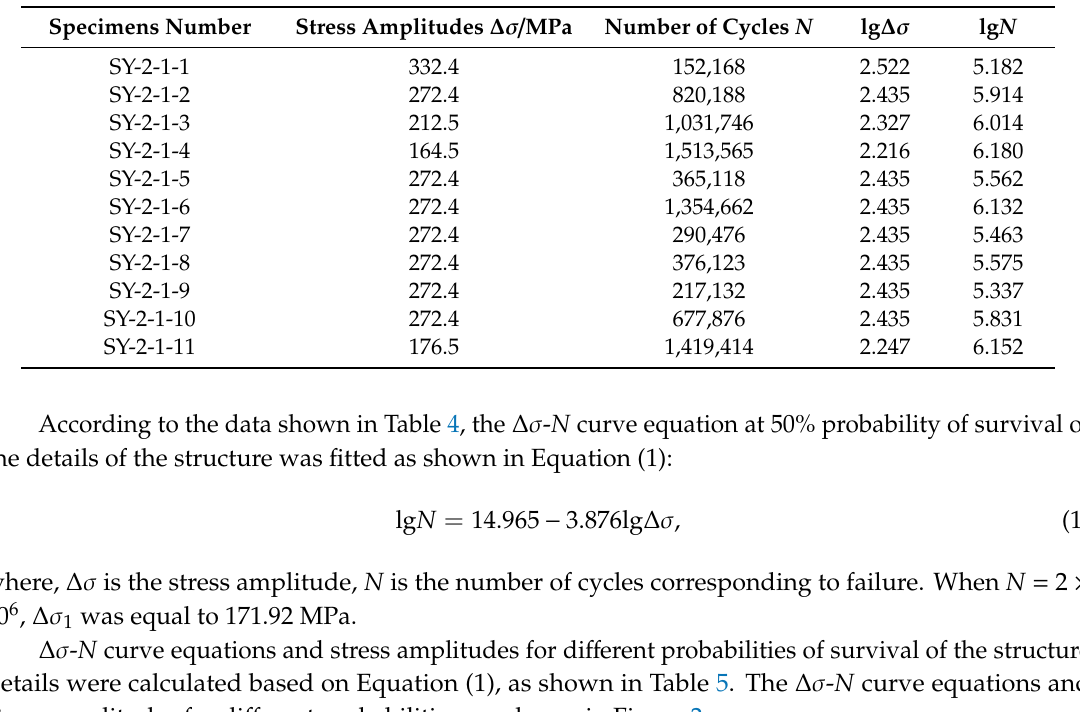
Table 4. Fatigue test results of eleven specimens.